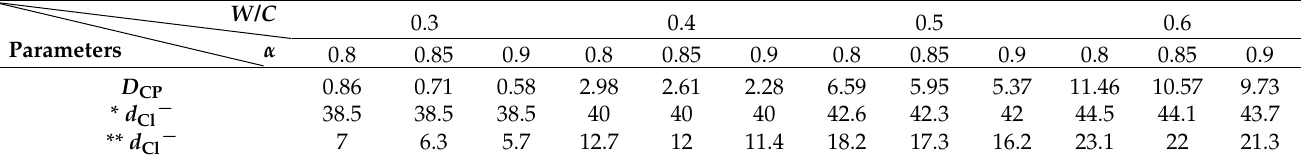
Table 2. Parameters including diffusion coefficient in CP ( D CP , × 10 − 12 , m 2 /s) and diffusion depth ( d Cl − , mm) of chloride in concrete with different water–cement ratio ( W / C ) and degree of hydration( α